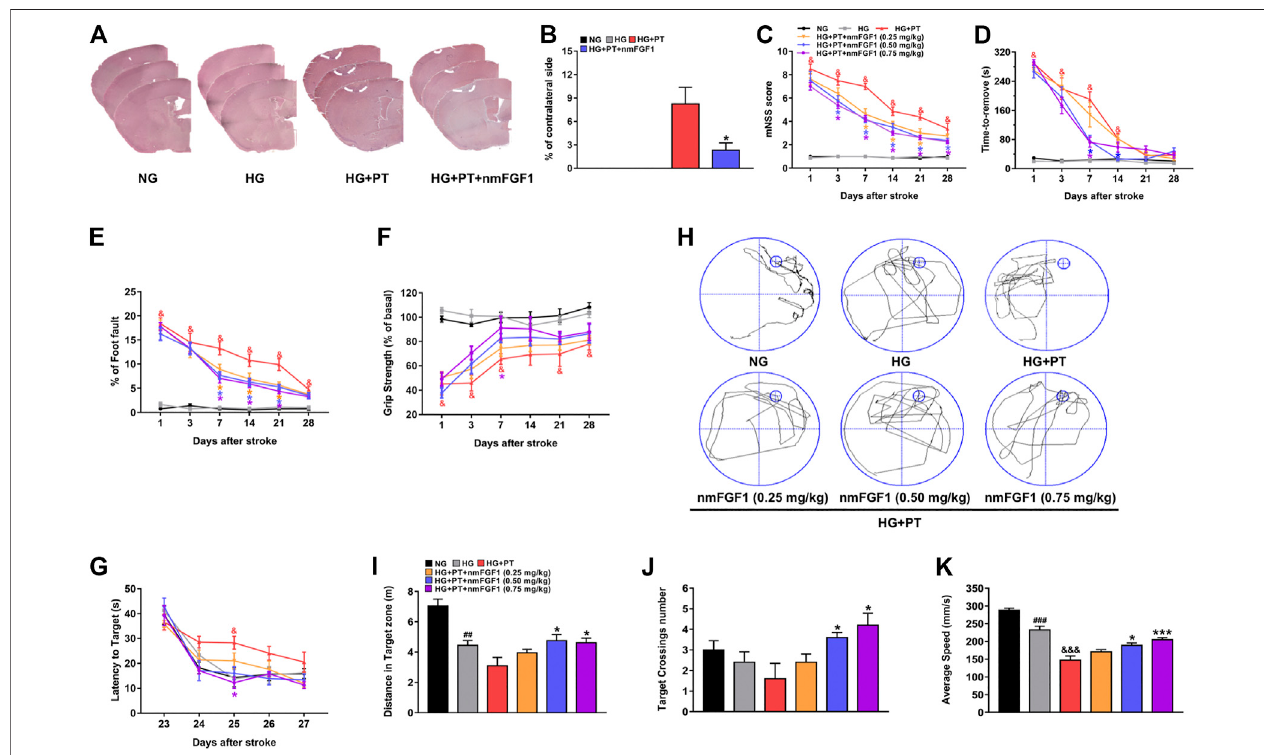
FIGURE 2 | NmFGF1 attenuated infarct size and neurobehavioral de fi cits in a mouse model of diabetic stroke. (A, B) The infarction size on day 7 after ischemic stroke was observed by HE staining, and quanti fi ed by measuring the size of the cerebral infarction (n (cid:2) 3). (C – F) Data derived from the mNSS, adhesive removal test, foot fault test, and grip strength test, on days 1, 3, 7, 14, 21, and 28 after stroke in diabetic mice (n (cid:2) 8). Learning and memory de fi cits at 23 – 28 days after stroke were evaluated by the Morris water maze test. (G) Changes in the latency to reach the platform during the training period. (H) Representative images of swim routes to locate the platform in the mice in the different groups. (I) The distance traveled in the target quadrant. (J) The number of platform crossings during the probe trail. (K) Swimming speed in the platform quadrant (n (cid:2) 5). Data are presented as means ± SEM. ## p < 0.01, ### p < 0.001 vs. NG group; & p < 0.05, &&& p < 0.001 vs. HG group; * p < 0.05, *** p < 0.001 vs. HG + PT